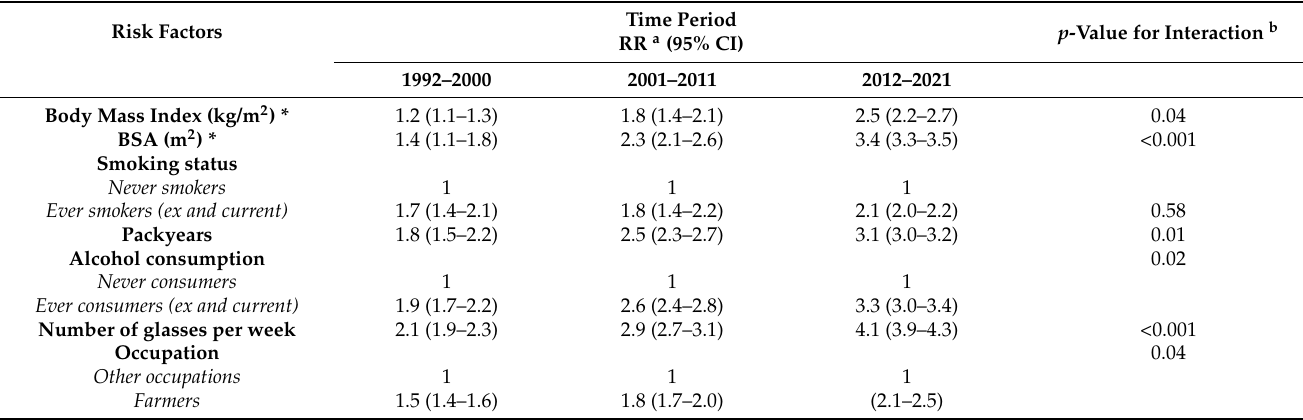
Table 2. Common risk factors among younger adults (under 50 years old) versus older adults (over 50 years old) and statistically significant changes among the three last decades (1992–2000, 2001–2011, 2012–2021).